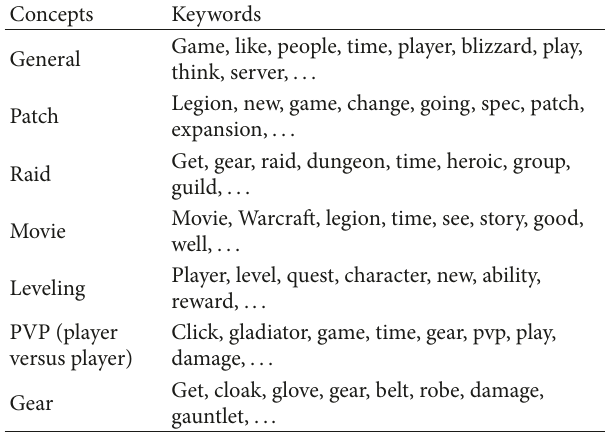
Table 1: Concept building example created and used in this